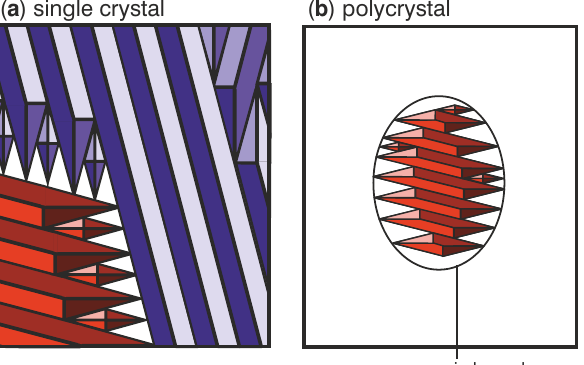
Figure 4. Sketches of the martensitic microstructure in films without grain boundaries ( a ) and with grain boundaries ( b ) illustrate the differences in twinning behaviour. For single crystalline films ( a ), martensitic nuclei can grow into long parallelograms well beyond the depicted area. In contrast, the growth of nuclei in polycrystalline films ( b ) is confined to the inside of the grain. For simplicity, the grain boundary is assumed to be oval and only the microstructure within one grain is shown. ( a ) reprinted from [3] with the permission of AIP